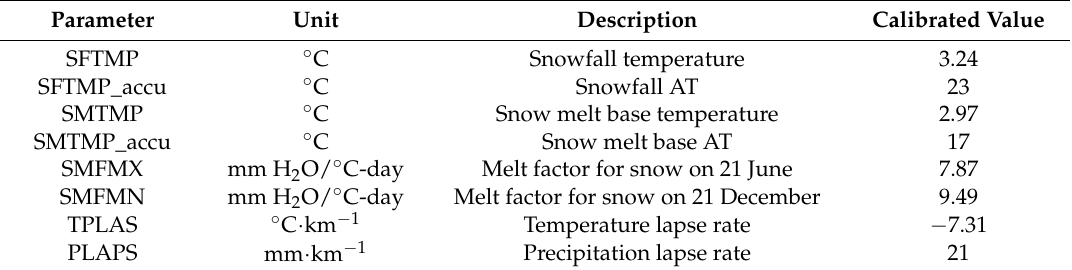
Table 2. Calibrated values of key parameters in the Soil and Water Assessment Tool Model (SWAT) simulation for the Tizinafu River Basin, Kunlun Mountains, Western